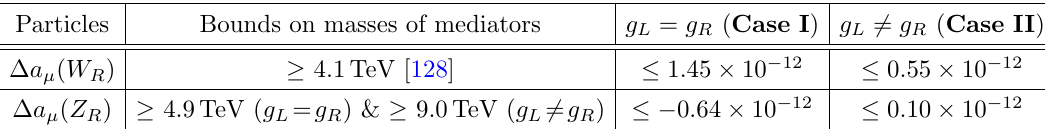
= g R . Relation between M W 6